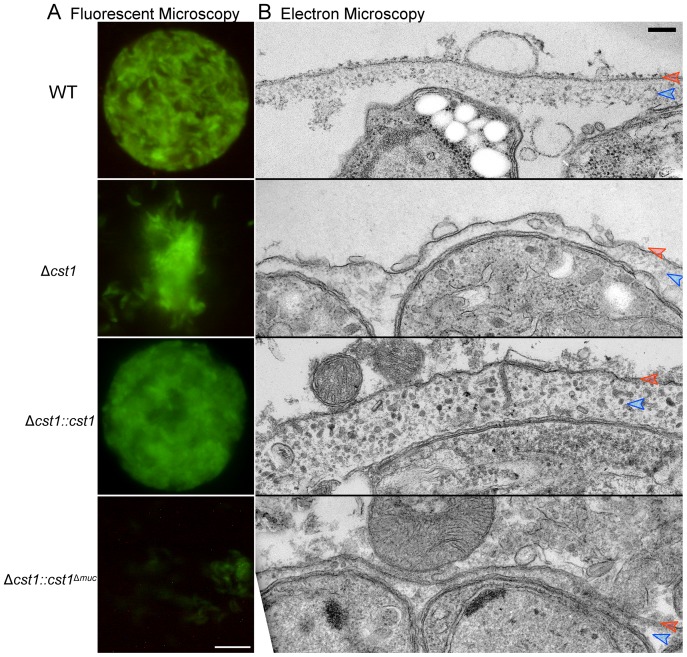
The mucin domain of CST1 is required to form mechanical stress-resistant cyst wall structures.(A) Brain cysts of WT and mutants after gentle brain homogenization, observed under epifluorescence microscopy. Bar, 10 µm. (B) Electron micrograph of T. gondii brain cysts demonstrates an alteration in the cyst wall with disruption and loss of the granular layer found underneath the cyst wall membrane. This disruption is visible in the Δcst1 and Δcst1::cst1
Δmuc cysts, but no disruption is seen in the WT and Δcst1::cst1 cysts. Red arrows indicate the cyst wall membrane and the blue arrows indicate the cyst wall granular layer. Measurements of the cyst wall: WT 153±28 nm, Δcst1 24±10 nm, Δcst1::cst1 284±65 nm, and Δ cst1::cst1
Δmuc 34±14 nm (p<0.05 WT vs Δcst1, WT vs Δ cst1::cst1
Δmuc, and WT vs Δ cst1::cst1). The original image magnification was 20,000× on all of these EM images. Bar, 200 nm.